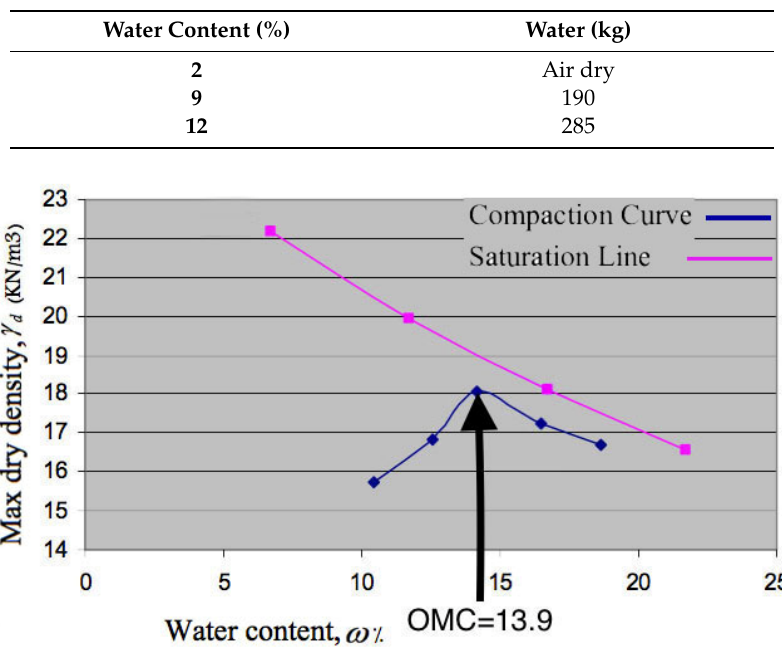
Figure 2. Graph from compaction test. OMC, optimum water content.